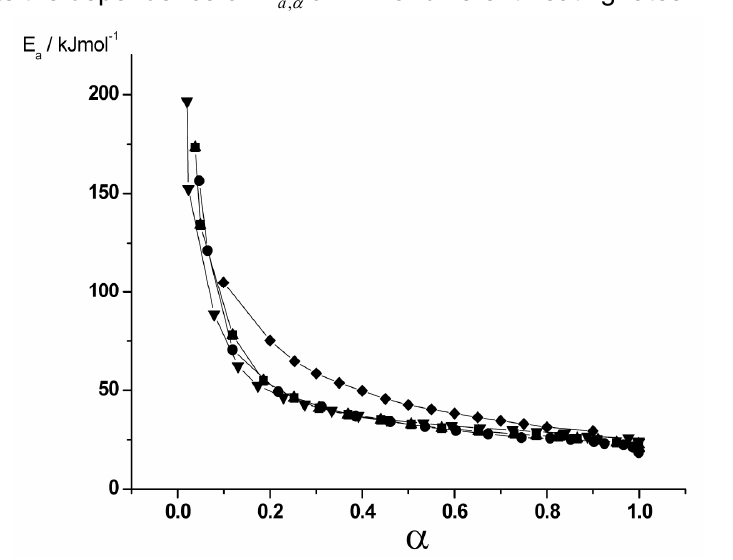
E on  for different heating rates , a  E от  при различных скоростях нагревания a E од  на различитим брзинама , a 